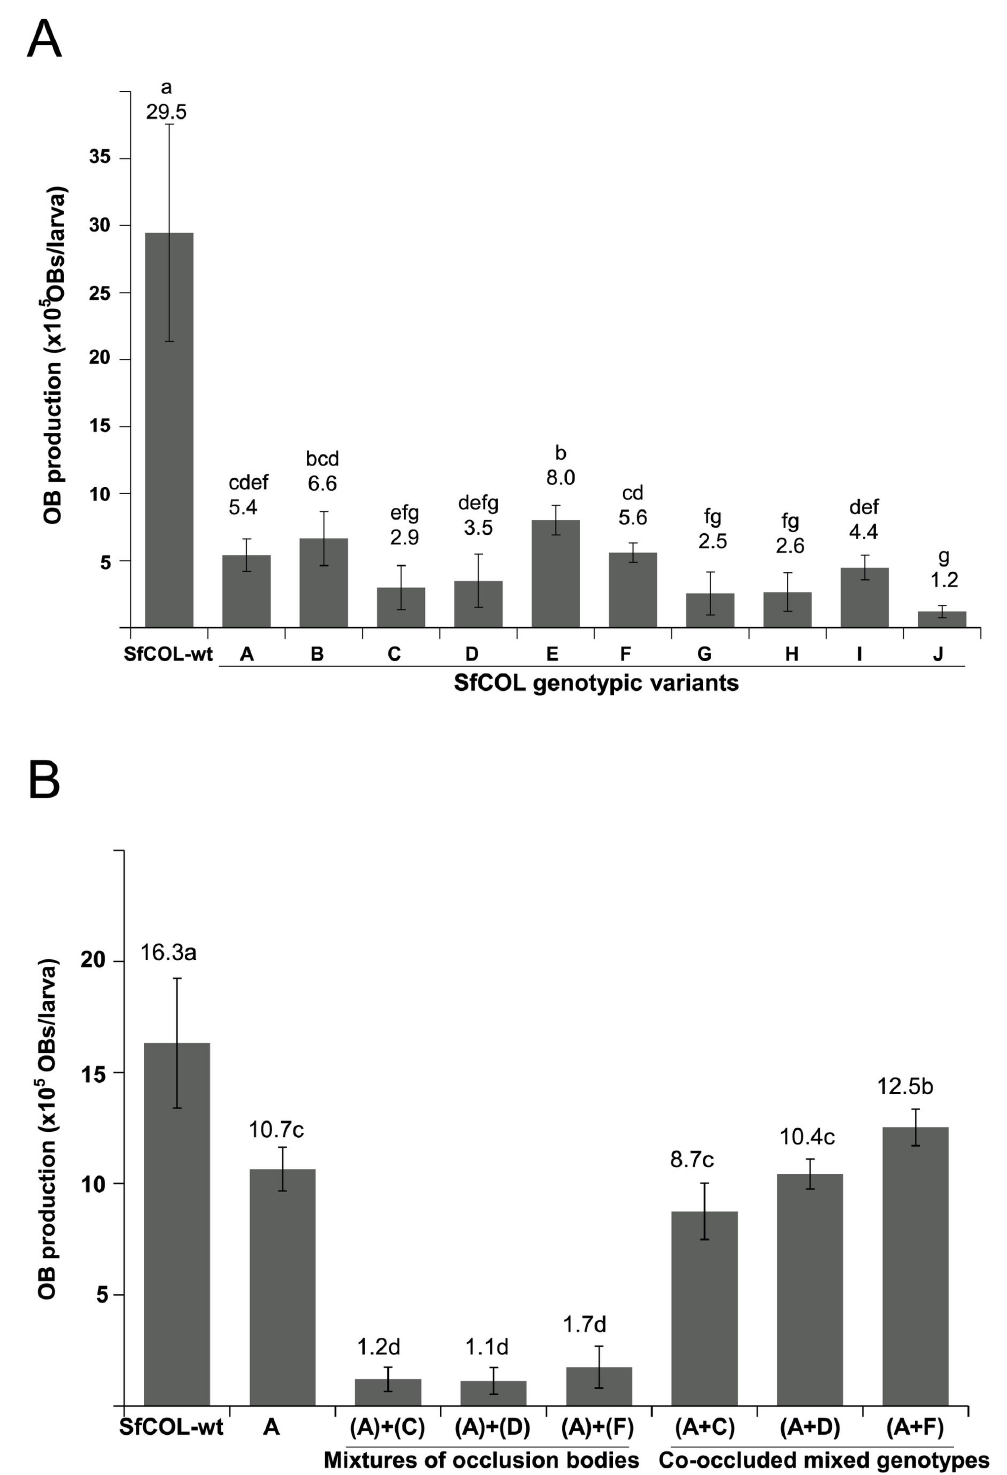
Figure 3. Production of occlusion bodies (OBs) in second instar S. frugiperda . A. Median OB production per larva of SfCOL- wt and genotypic variants in S. frugiperda inoculated in the second instar. B. Median OB production per larva of SfCOL-wt, SfCOL-A and OB mixtures and co-occluded genotype mixtures comprising equal proportions of SfCOL-A and -C, -D or –F genotypes. Vertical lines indicate the interquartile range. Values followed by different letters indicate significant differences (P≤0.05). doi: 10.1371/journal.pone.0077271.g003 PLOS ONE |